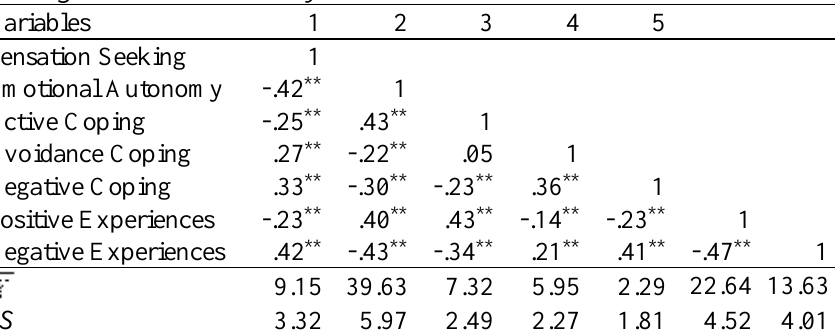
Findings of Correlation Analysis